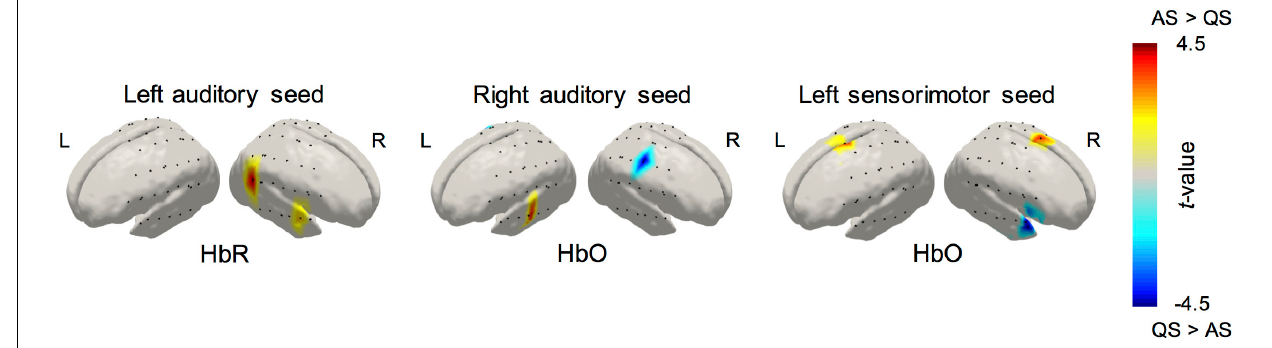
FIGURE 4 | Group differences in RSNs revealed by the paired t -tests of the seed-based correlation method between active and quiet sleep. Results for HbO and HbR are displayed for those statistical tests that survived the seed level FDR correction criterion ( q <